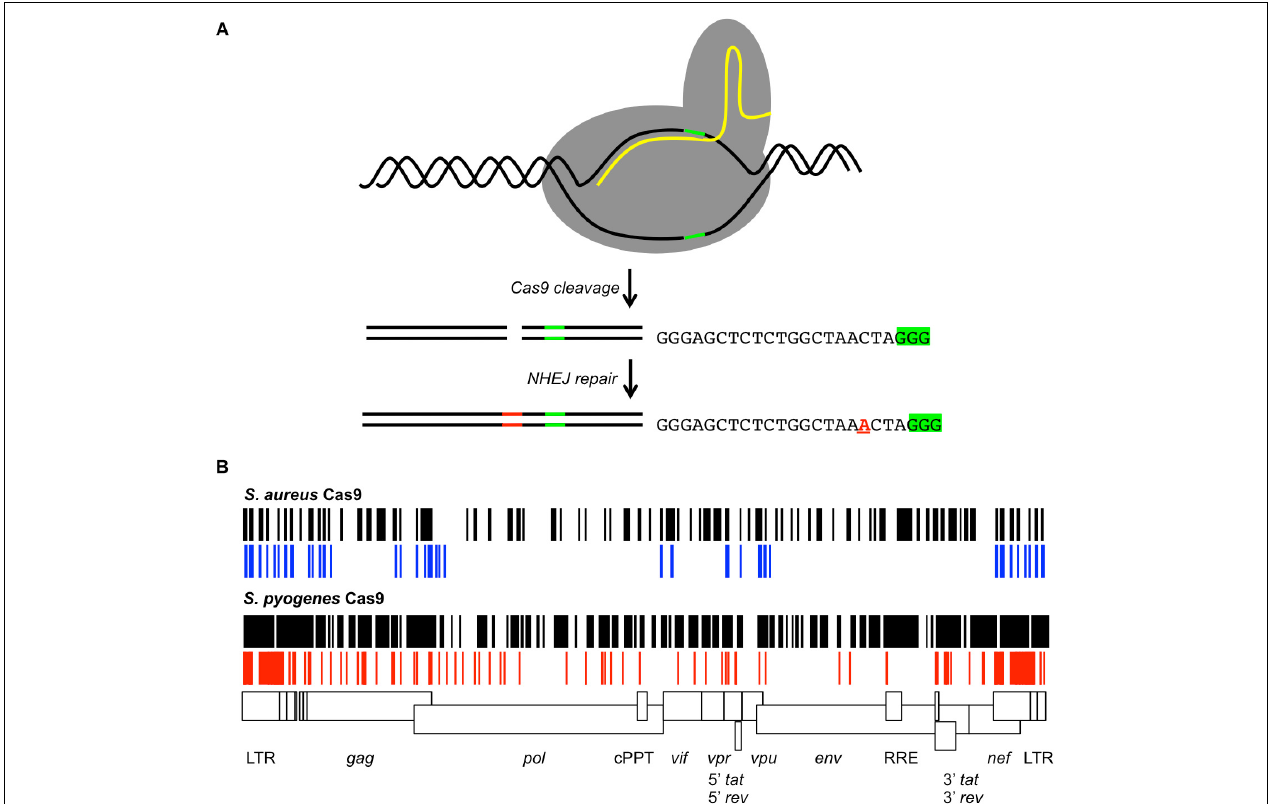
FIGURE 2 | CRISPR/Cas9 gRNAs targeting the HIV-1 provirus. (A) Cartoon of Cas9 cleavage of target DNA. The Cas9 protein (gray) binds the target DNA (black lines) and gRNA (yellow line). The PAM signal (green line) is adjacent to the gRNA homology region. Cas9 generates a DSB 3 bp 5 (cid:48) of the PAM. DNA repair by NHEJ may insert or delete nucleotides (red lines) at the cleavage site. As an example, the sequence of a gRNA targeting the HIV-1 TAR element is shown with the PAM signal 5 (cid:48) -GGG-3 (cid:48) (green highlight). The observed repair products included insertion of a single nucleotide at the cleavage site (red A) (Yoder and Bundschuh, 2016). (B) The possible S. aureus or S. pyogenes gRNAs throughout the proviral genome of the laboratory strain HXB2 for Cas9 are shown (black) relative to a scale map of the HIV-1 genome. Previously reported S. aureus gRNAs are shown in blue, S. pyogenes gRNAs in red. Features of the HIV-1 genome are indicated by boxes. Differences between the possible gRNAs and reported gRNAs are due to strain